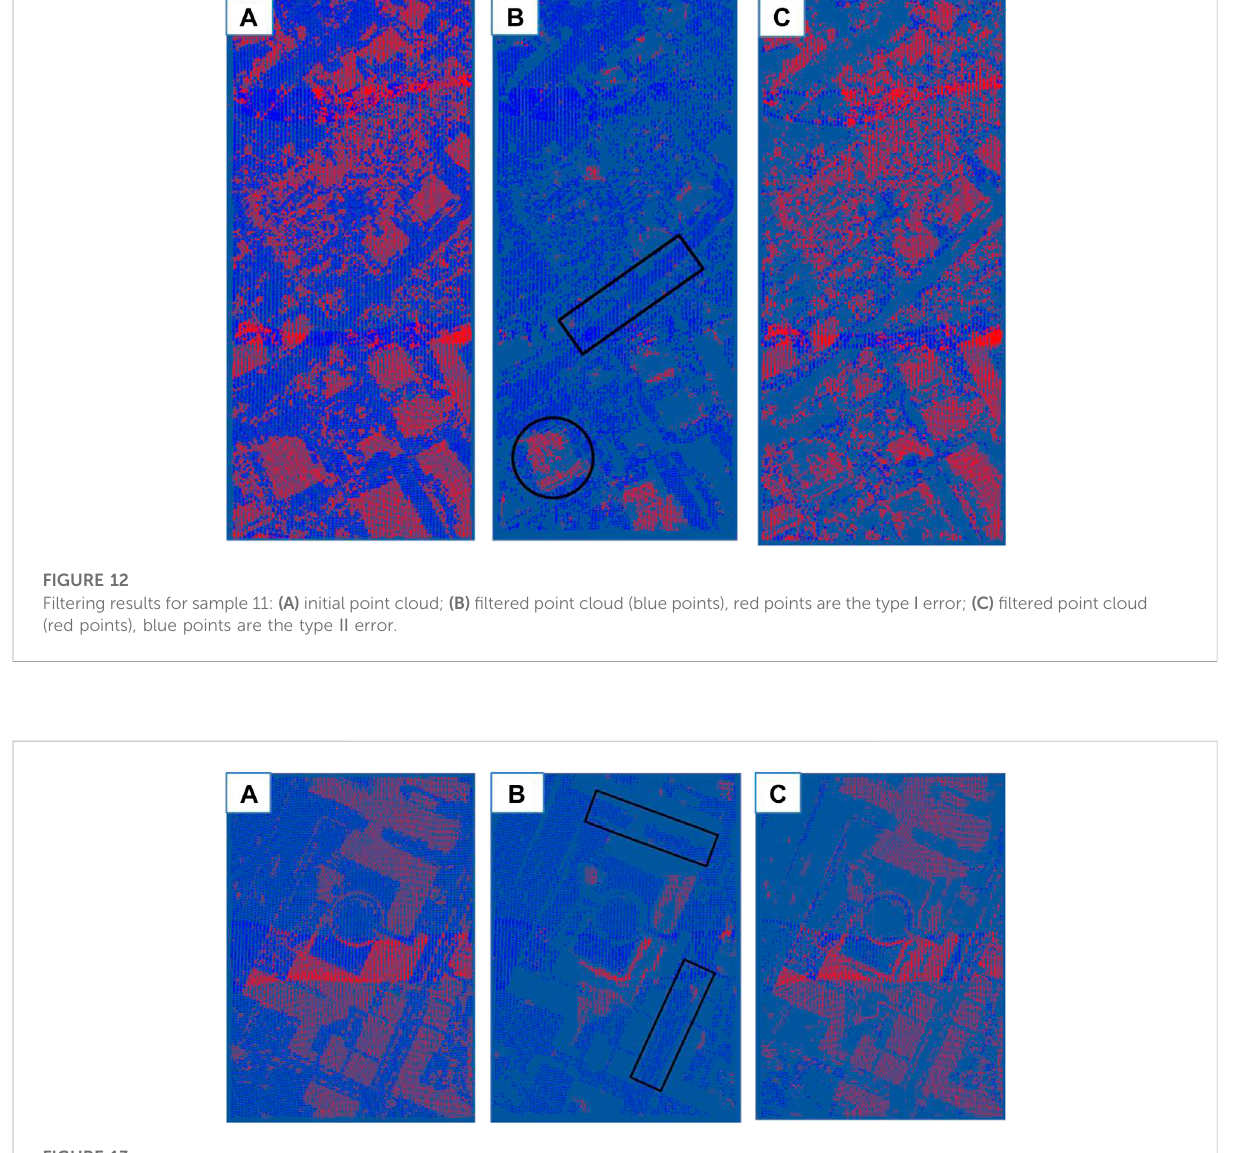
FIGURE 13 Filtering results for sample 23: (A) initial point cloud; (B) fi ltered point cloud (blue points), red points are the type Ⅰ error; (C) fi ltered point cloud (red points), blue points are the type Ⅱ